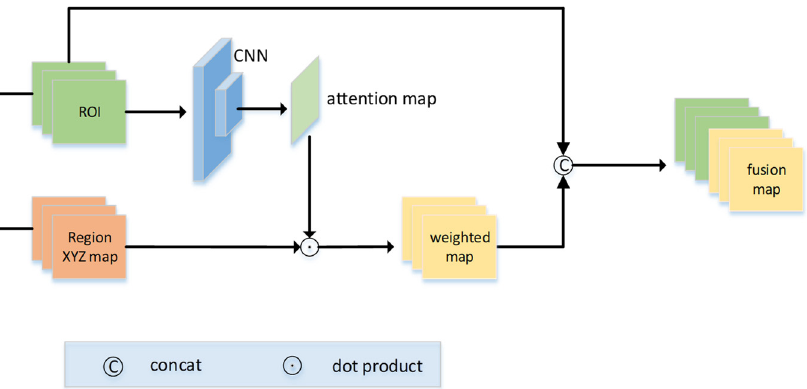
Figure 3. Information fusion process with attention mechanism of 2D region of interest and region pseudo ‐ lidar.